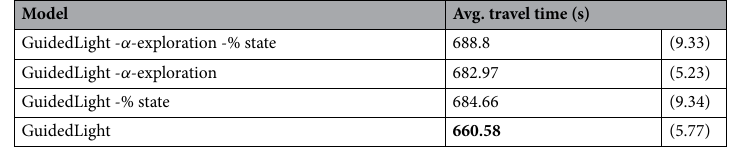
Table 3. Results of the ablation study on the NY196 scenario. Bold Indicates result with the lowest average travel time. -% state indicates a model using absolute number of vehicles instead of road length adjusted coverage, - α -exploration indicates a model using random exploration. The values in brackets indicate the standard deviations of the last 10 training epochs.